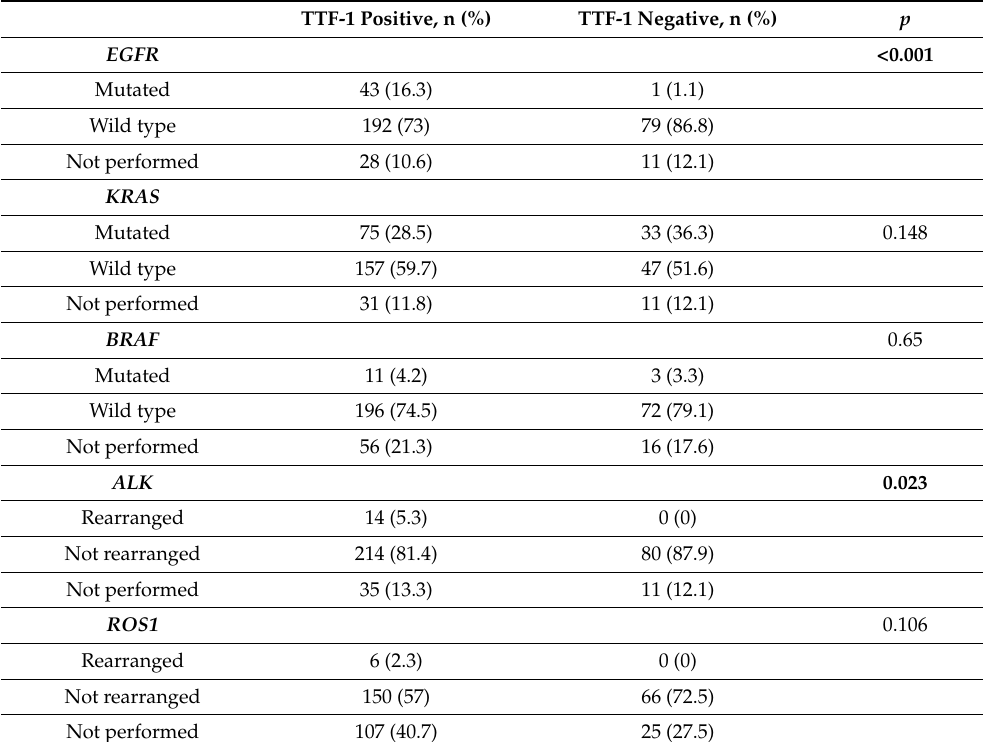
Table 2. Molecular alterations between TTF-1 positive and TTF-1 negative groups.